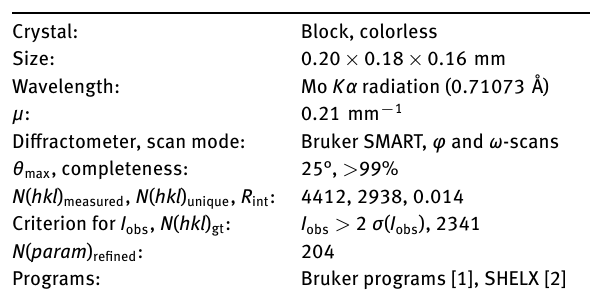
Table 1: Data collection and handling.